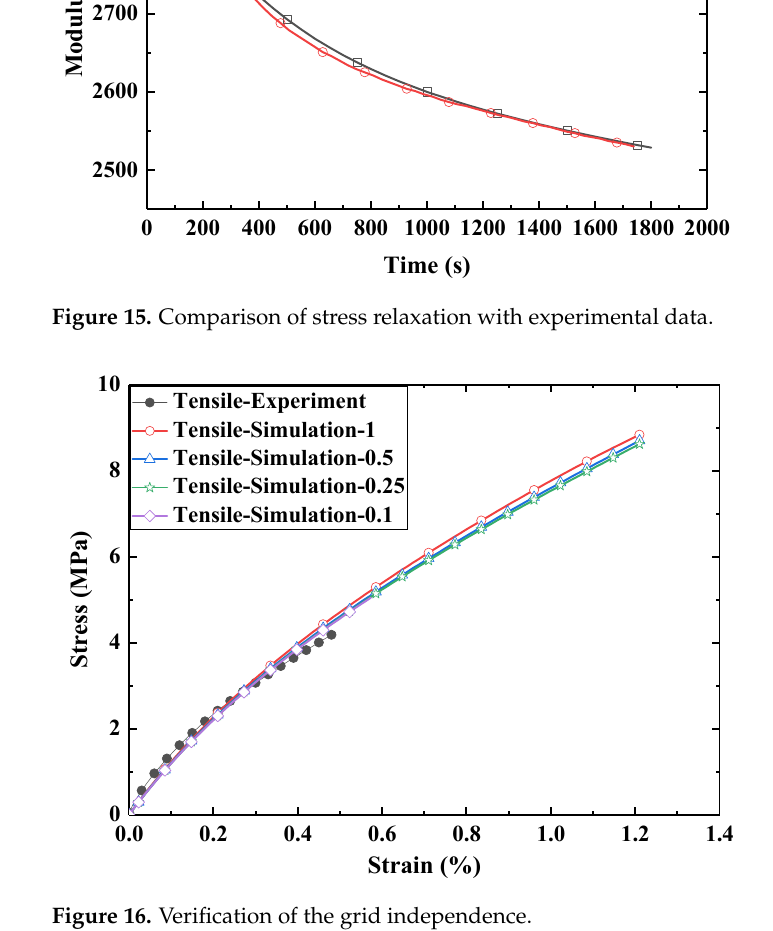
Figure 16. Verification of the grid independence.